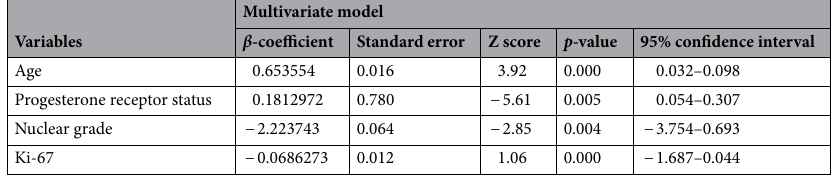
Table 3. Multivariate logistic regression model.